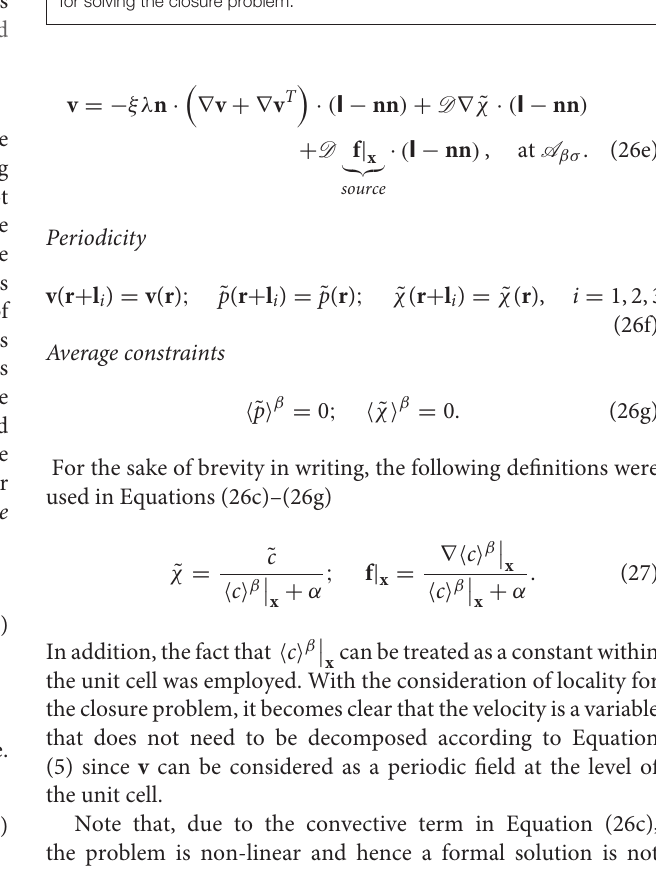
FIGURE 2 | Sketch of a two-dimensional periodic unit cell, of side length ℓ c , for solving the closure